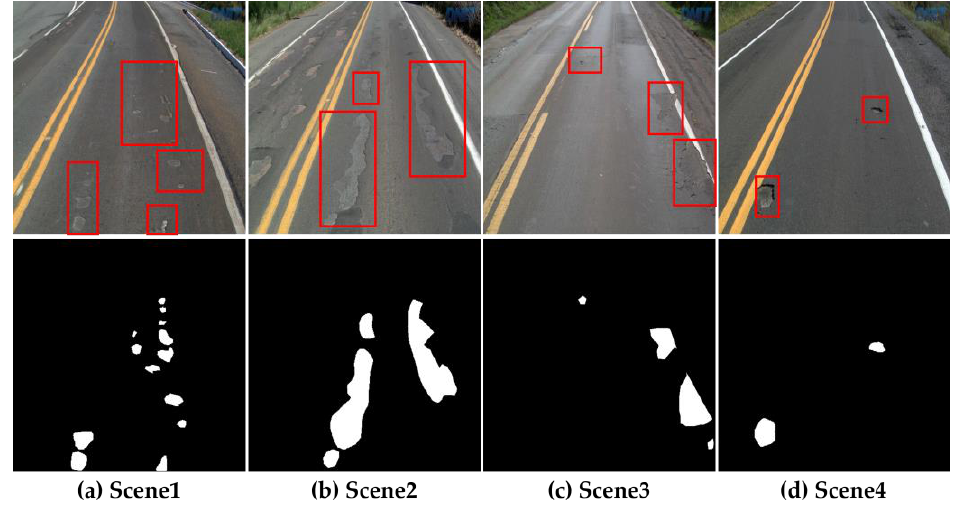
Figure 3. Visualization of the sample images from the CPRID. The first row is the source image and the second row is the label image. The red border crater in the first row of the source image corresponds to the white block pattern in the label image.